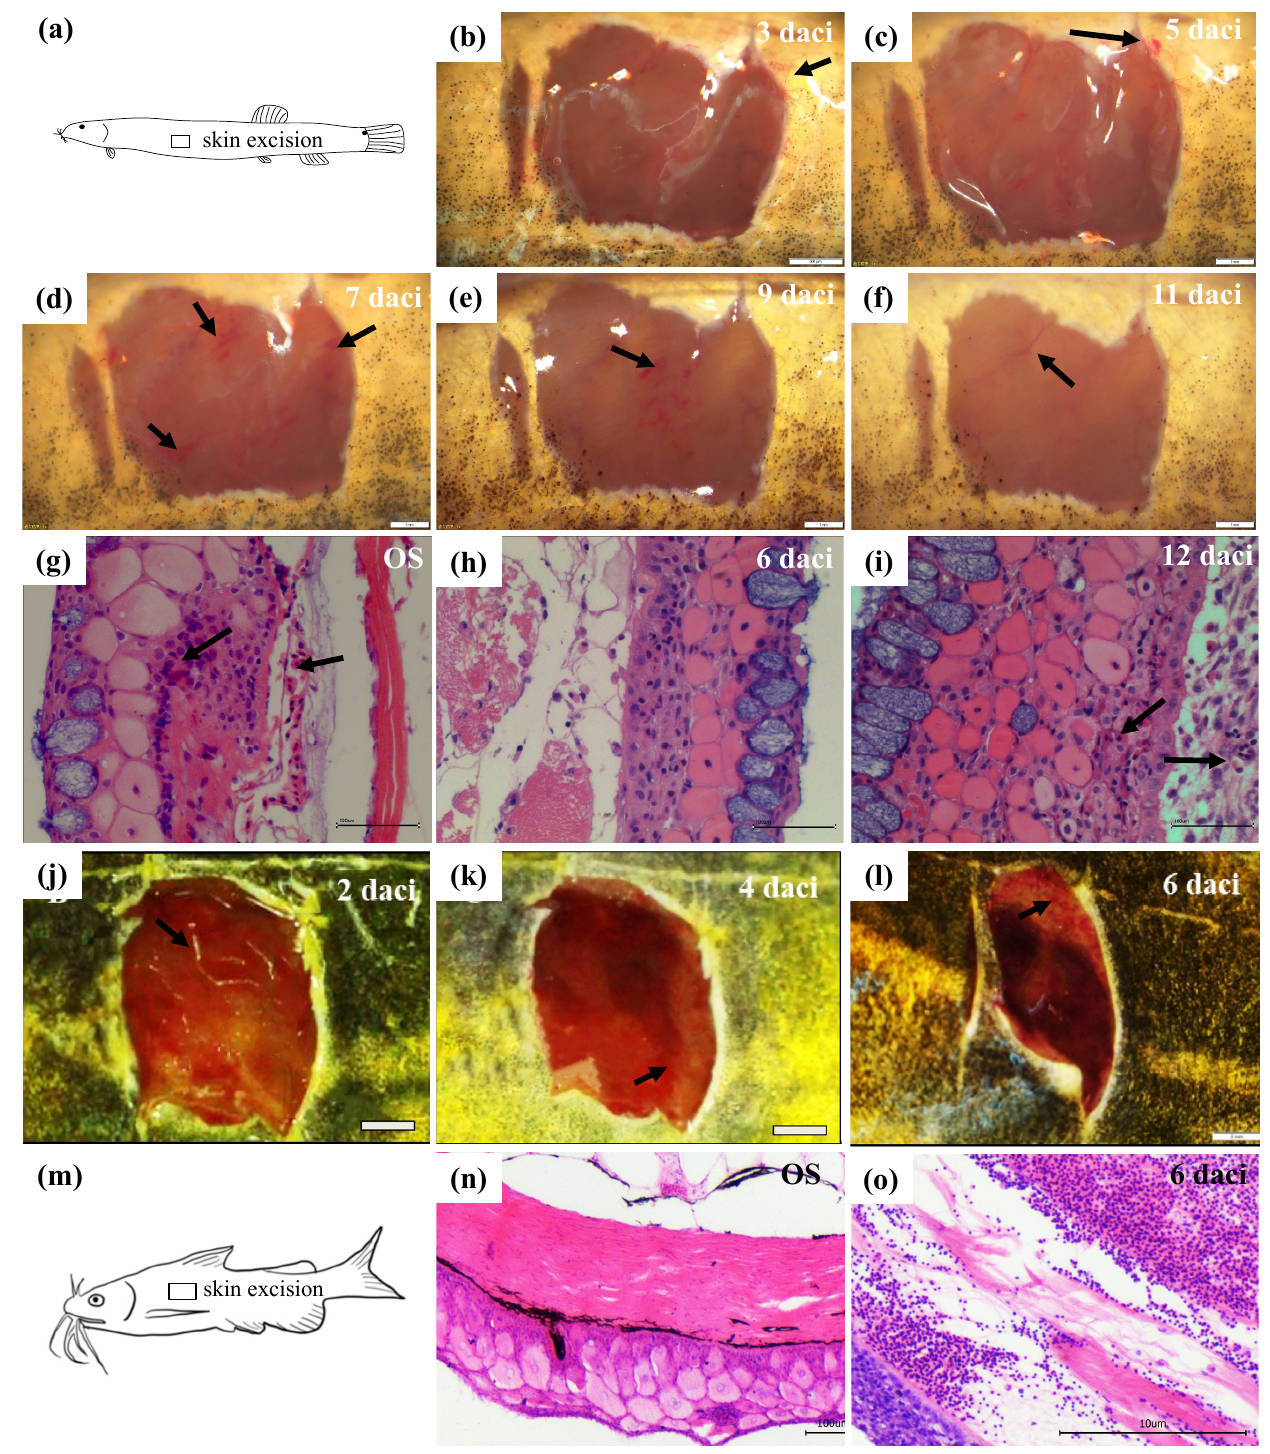
Figure 1. Morphological and histological observations of regenerated skins of loach and yellow catfish. ( a ) Sketch map of cutaneous incision for morphological observations of regenerated skins. ( b – f ) Morphologies of regenerated skins of the 3rd, 5th, 7th, 9th, and 11th day after cutaneous incision (daci) of loach. Scale bars indicate 1 mm. ( g – i ) Histological structures of original skin (OS) and regenerated skins of the 6th and 12th daci of loach. Scale bars indicate 10 µ M. Black arrows show blood vessels. ( j – l ) Morphologies of regenerated skins of the 2nd, 4th, and 6th daci of yellow catfish. Scale bars indicate 1 mm. ( m ) Sketch map of cutaneous incision for morphological observations of regenerated skins. ( n , o ) Histological structures of original skin (OS) and 6th daci regenerated skin in yellow catfish.